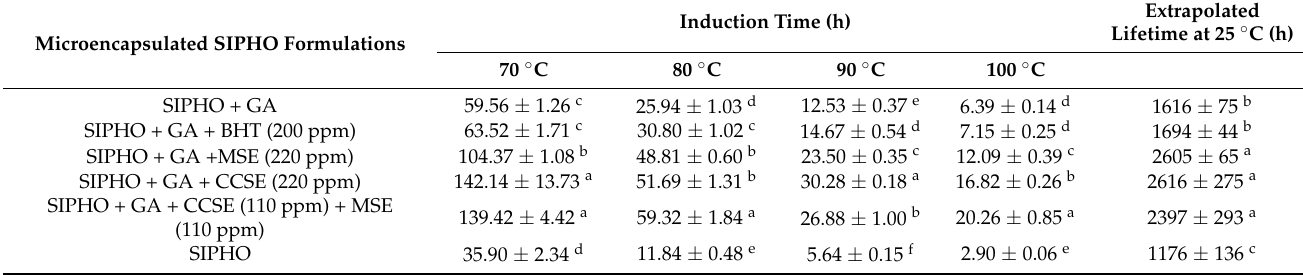
Table 8. Lifetime (h), by Rancimat method, of sacha inchi ( P. huayllabambana ) oil (SIPHO)